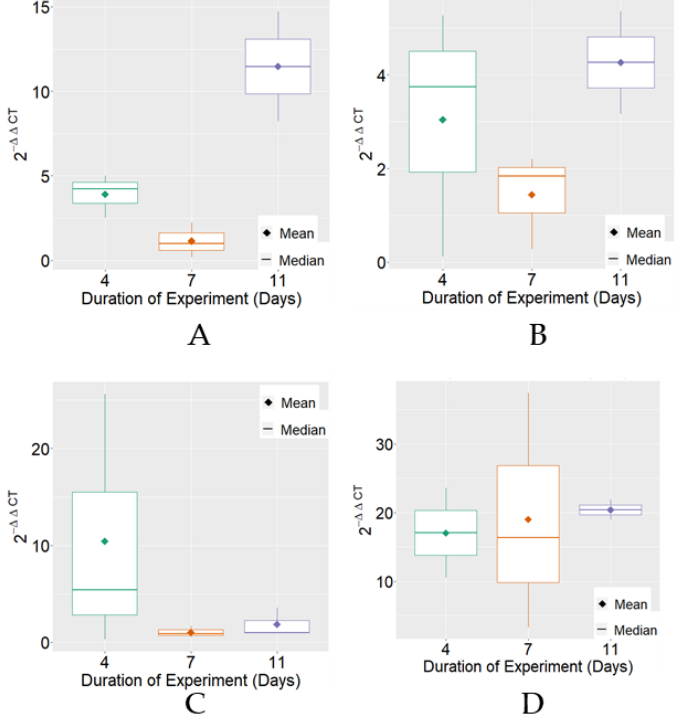
Figure 1. Boxplot of variable 2 − ∆∆ CT for MRJP3 mRNA expression for each treatment. ( A ) Negative Control; ( B ) Positive Control; ( C ) BPF—basic protein feed; ( D ) FPP—protein feed with prebiotics and probiotics.